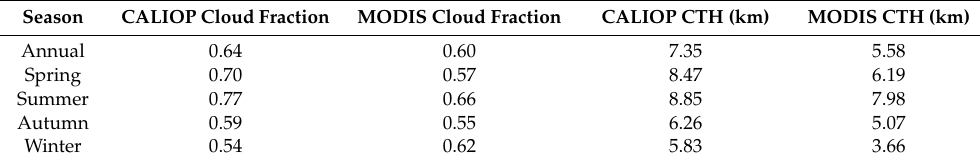
Table 1. MODIS and CALIOP averaged cloud fraction and CTH over Eastern